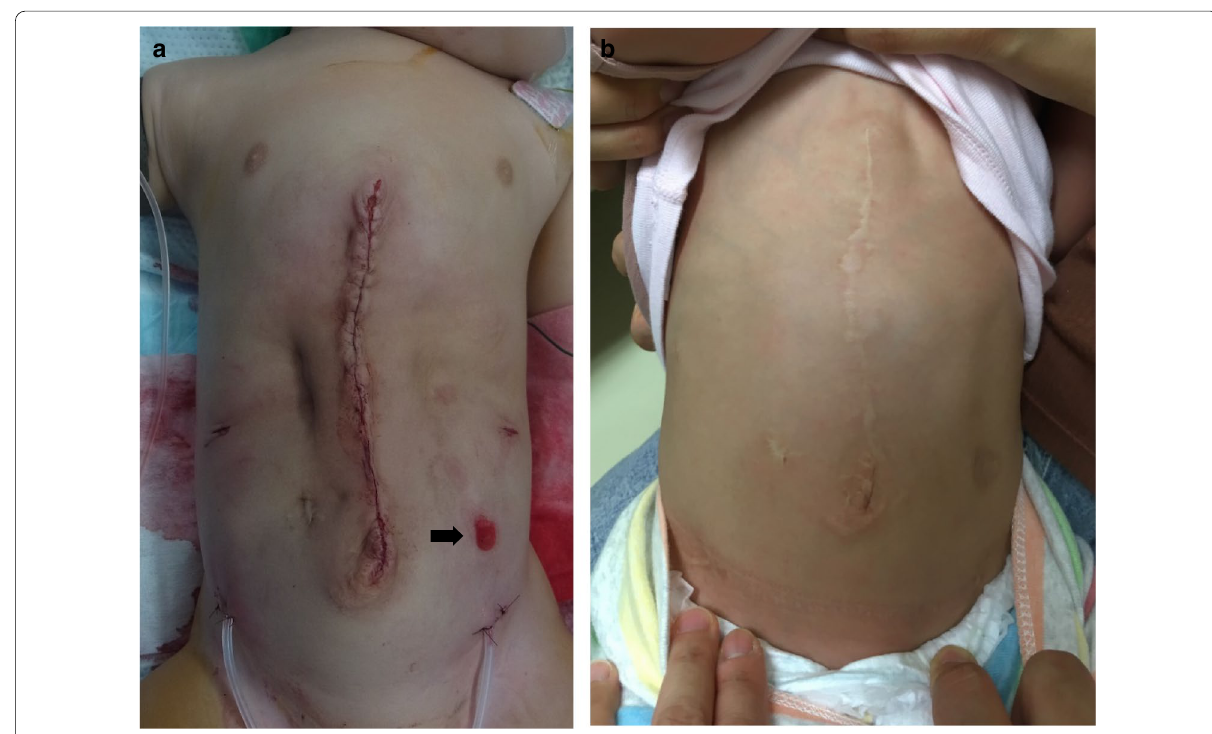
Fig. 6 a : Appearance of the patient just after ESCT, a small skin burn ( ➡ ) occurred on the left abdomen. Drains were placed in the created spaces from the inguinal wounds. b : Appearance of the patient at 4 years of